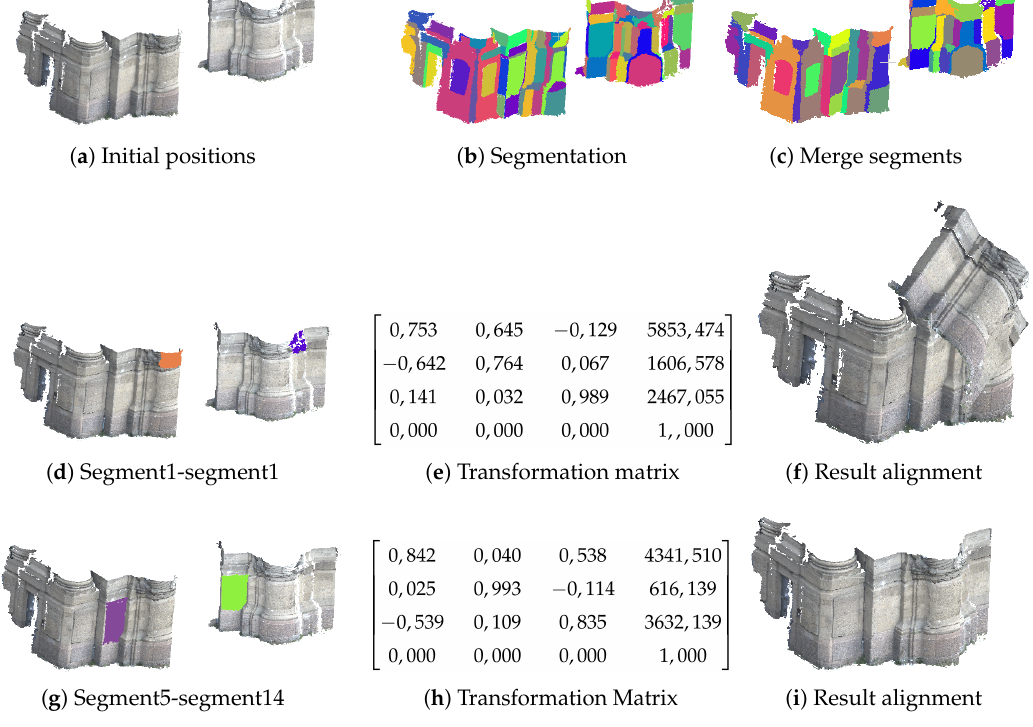
Figure 7. Some steps of the alignment of “CharlotteBürgerturm” dataset with LCP-4PCS: ( a ) Initial position of the scans, ( b ) Result of segmentation Scan1(foreground) 43 segments and Scan2(background) 37 segments, ( c ) Merging result Scan1(25 segments) and Scan2(22 segments), ( d ) Representation of the first segments of the scans, ( e ) Transformation matrix from the alignment of the first segments, ( f ) Alignment result using the matrix in “e” (number of matched segment: 1), ( g ) Representation segment8(Scan1) and segment13(Scan2), ( h ) Transformation matrix from the alignment of segment5 and segment14, ( i ) Alignment result using the matrix in “h”(number of matched segments: 8). Table 2. Performances of 4PCS and LCP-4PCS on our